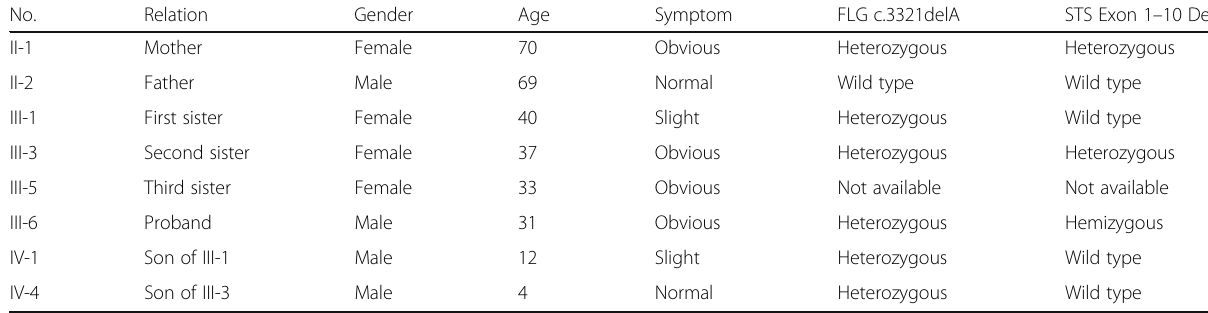
Table 1 STS and FLG mutation in a Chinese family with ichthyosis